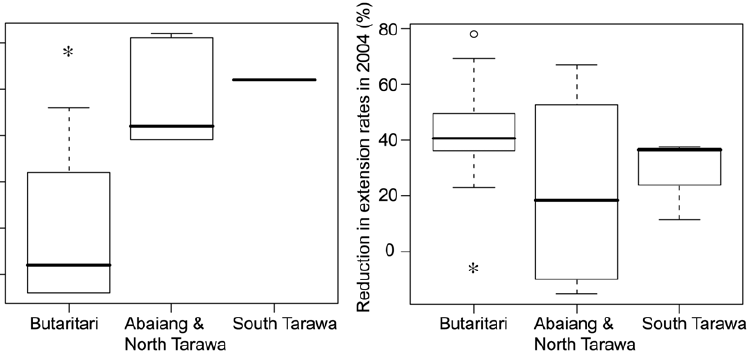
Figure 4. Boxplots of temperature variability and reduction in coral extension rates in 2004. The temperature variability metric at each site was calculated as the standard deviation of the maximum monthly SST from 1985–2003, scaled such that the mean for the world’s coral reefs is 1 u C [16]. Coral growth rate reductions are presented as the percentage that extension rates were reduced in 2004 compared to all previous years for each individual core. Asterisks indicate significant differences between measures at Butaritari versus Abaiang and North Tarawa. doi:10.1371/journal.pone.0034418.g004 PLoS ONE |